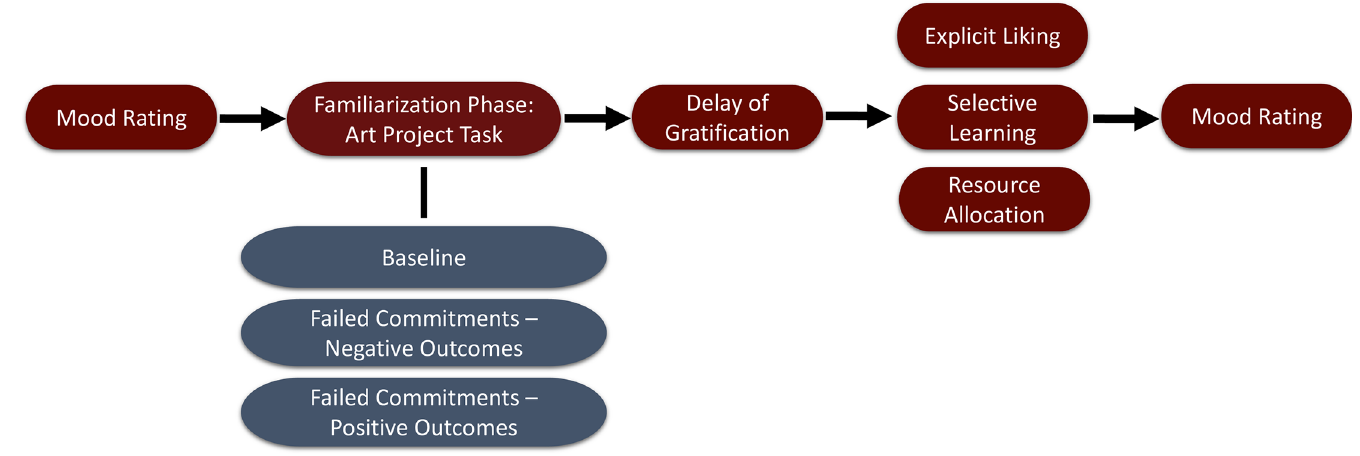
Fig 1. Flow chart of the